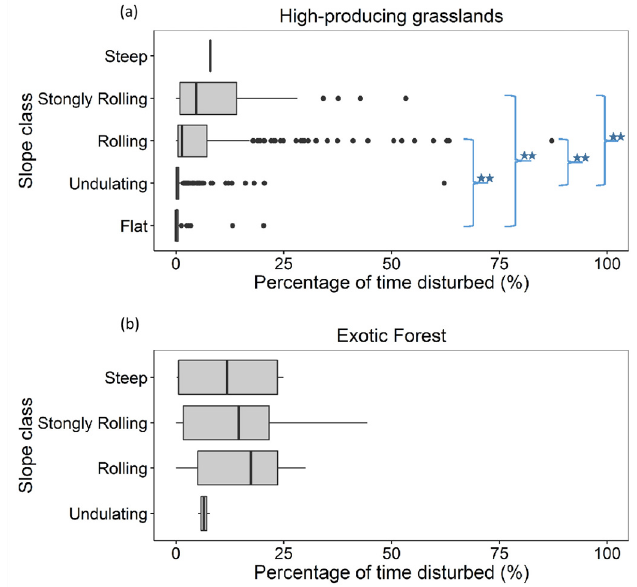
Figure 5. Wilcoxon rank sum test (Bonferroni correction) on disturbance values for different slope (flat, undulating, rolling, strongly rolling, and steep) and land cover classes: (a) high-producing grasslands and (b) exotic forest. Statistical significance between classes is shown with blue stars ( p -value < 0.001) on the boxplots.